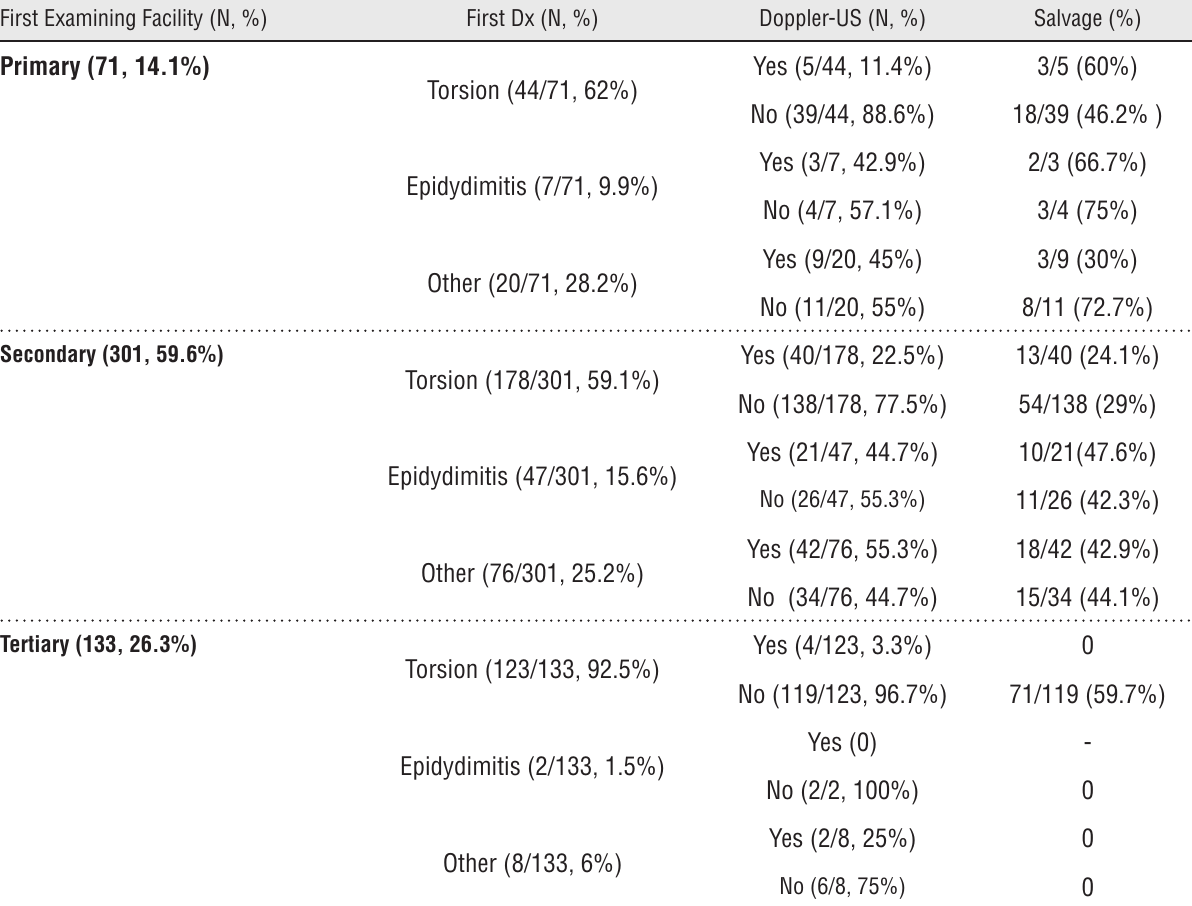
Legend to Table 1 - Patient distribution according to first examination facility level-of-care facility (Primary, Secondary, Tertiary), first diagnosis, Doppler-US request and testicular surgical salvage. First Dx, diagnosis at first examining facility, Torsion, testicular torsion; Epidydimitis, acute epidydimitis; Other, neither testicular torsion nor